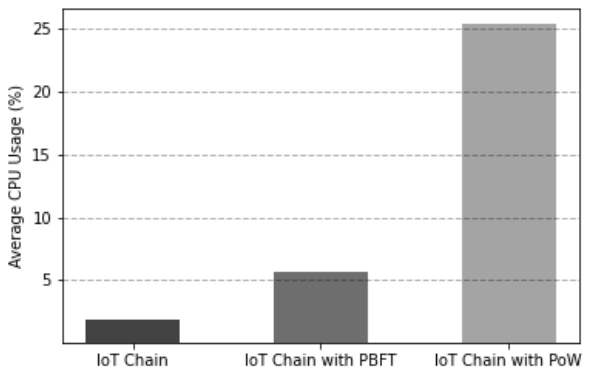
Figure 12. CPU usage comparison according to IoT-Chain consensus